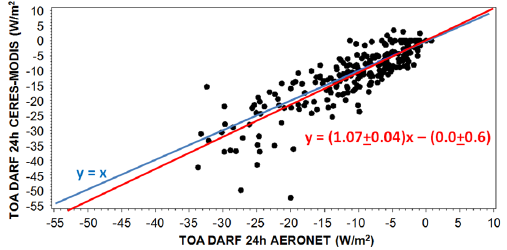
Figure 6. Intercomparison between the mean daily direct radiative forcing (24h-DARF) at the top of the atmosphere (TOA) evaluated using CERES-MODIS and by AERONET inversion